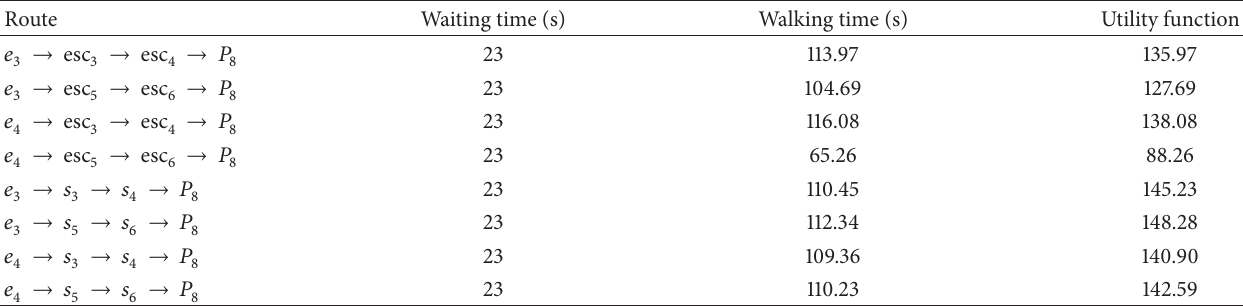
Table 5: Utility functions of